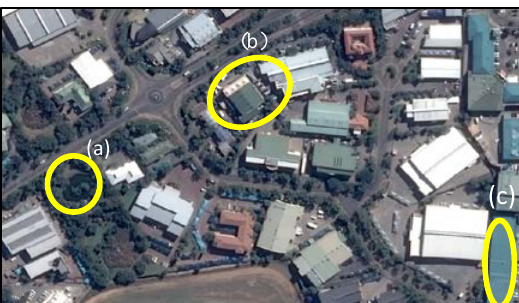
Figure 4: Selected extracts from high spatial resolution Pleiades data: (a) area showing water; (b) area showing shadows of buildings; (c) area showing roof of a building